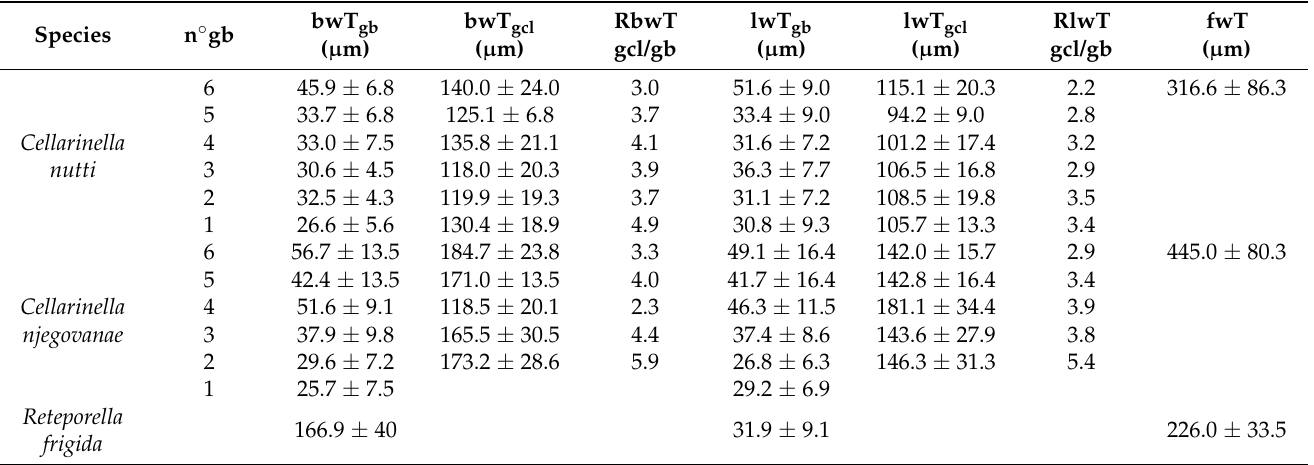
Table 3. Number of growth bands (n gb), zooid basal wall thickness from growth bands (bwT gb ) ( µ m), zooid basal wall thickness at growth check lines (bwT gcl ) ( µ m), ratio between bwT gcl bwT gb (RbwT gcl/gb); zooid lateral wall thickness from growth bands (lwT gb ) ( µ m), zooid lateral wall thickess at growth check lines (lwT gcl ) ( µ m) and ratio between lwT gcl lwT gb (RlwT gcl/gb); frontal wall thickness (fwT) in Cellarinella nutti and Cellarinella njegovanae . BwT, lwT and fwT in Reteporella frigida . Averages (n = 30) ±